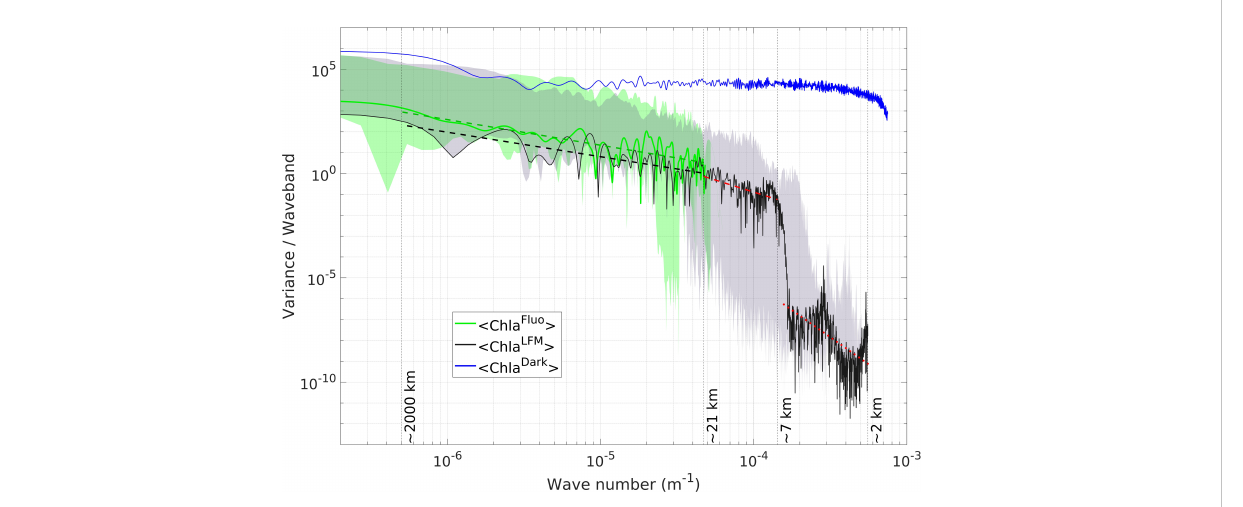
FIGURE 8 Variance spectrum of <Chla> from observations and model predictions along the trajectory of Tag 11. Increasing wave numbers correspond to smaller spatial scales (see Section 2.6). The green (black) solid line represents the variance per waveband of the <Chla Fluo > (<Chla LFM >) signal. The blue solid line represents the variance spectrum of dark KL . The green (gray) shaded area represents the envelope of the <Chla Fluo > (<Chla LFM >) spectra. The envelope encompasses the minimum and the maximum variances per waveband obtained in the dataset of the 18 SES tags included in the present study. The green (black) dashed line represents the linear regression of the variance spectra of <Chla Fluo > (<Chla LFM >) on the spatial scale interval between ~2 000 km and ~21 km, with a spectral slope equal to -1.22 (-1.17). The dashed (dotted) red line represents the linear regression of the variance spectrum of <Chla LFM > on the spatial scale interval between ~21 km and ~7 km (~7 km and ~2 km). The exact corresponding wave numbers are 5 10 -7 m -1 (~2 000 km), 4.7 10 -5 m -1 (~21 km), 1.4 10 -4 m -1 (~7 km) and 5 10 -4 m -1 (~2 km). (For the determination of the thresholds used for the piecewise linear regressions calculated on the variance spectra of <Chla Fluo > and <Chla LFM >, see supplementary material, Text S7 and Figures